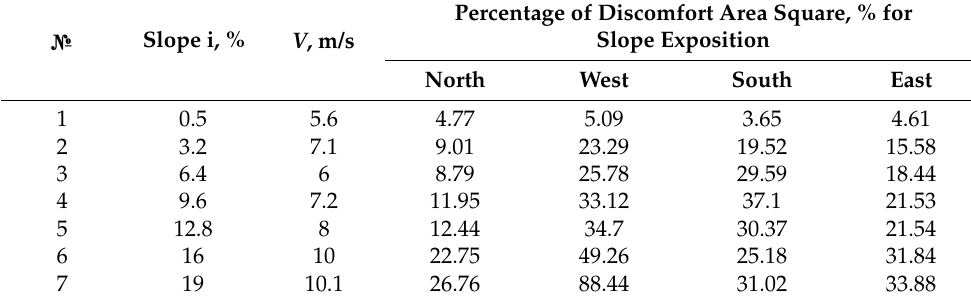
Table 3. The proportion of uncomfortable areas under average temperature of − 18 ◦ C in the total area of each